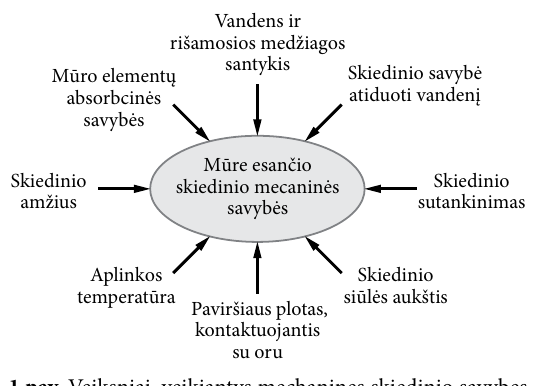
standesnis už skiedinį Fig. 2. Model of stress state in masonry components, when the unit is stiffer than the